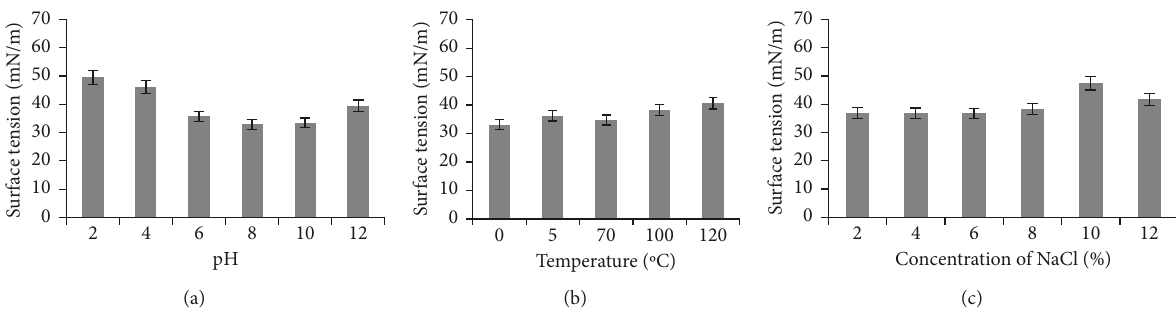
Figure 3: Stability studies for biosurfactant produced by Cunninghamella echinulata in the medium constituted by instant noodle waste 2% (INW), corn steep liquor 2% (CSL), and soybean waste oil 0.5% (SWO), under different conditions: pH (a), temperature (b), and NaCl